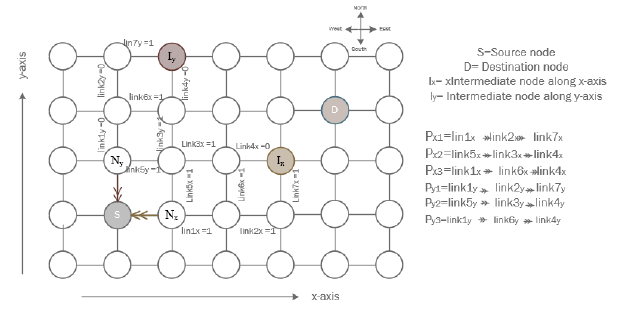
Fig. 1. Intermediate node I x and I y are determined in the NE quadrant of destination node D and I y selected based on the least congested path P y3 An Intermediate node is a predefined node calculated from the location of the source node and destination node quadrant. If source node having location of S , intermediate node along x-axis is (x,y) calculated as I =I for NE quadrant, I =I x (x-1,y+3) x (x+1,y+3) for ES quadrant, I =I for NW quadrant, I =I x (x-1,y-3) x (x+1,y- for WS quadrant nearer to destination node and 3) along y-axis is calculated as I =I for NE y (x-3,y+1) quadrant , I =I for ES , I =I for NW and y (x+3,y+1) y (x-2,y-1) I =I for WS quadrant. y (x+3,y-1)